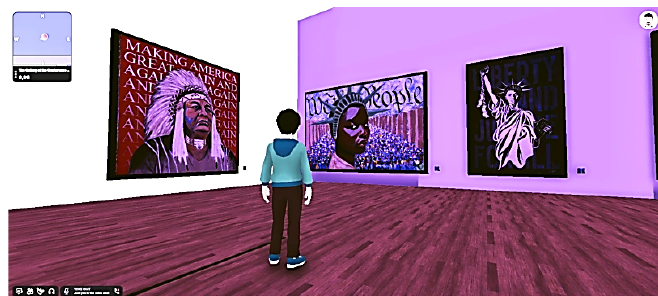
Figure 42: Prof Naseem Naqvi at an art gallery in the Decentraland